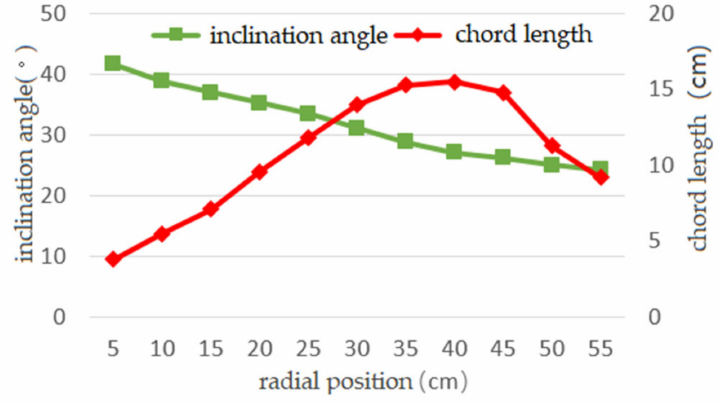
Figure 11. Curves of inclination angle and chord length of lift–drag arc blades.